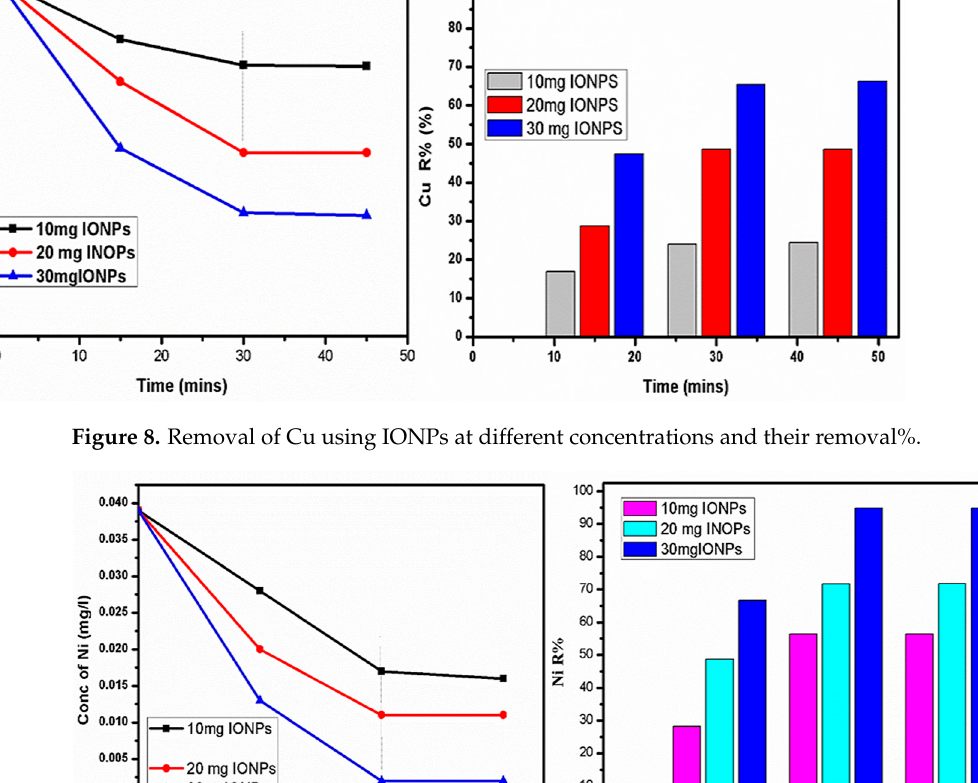
Figure 8. Removal of Cu using IONPs at different concentrations and their removal%.